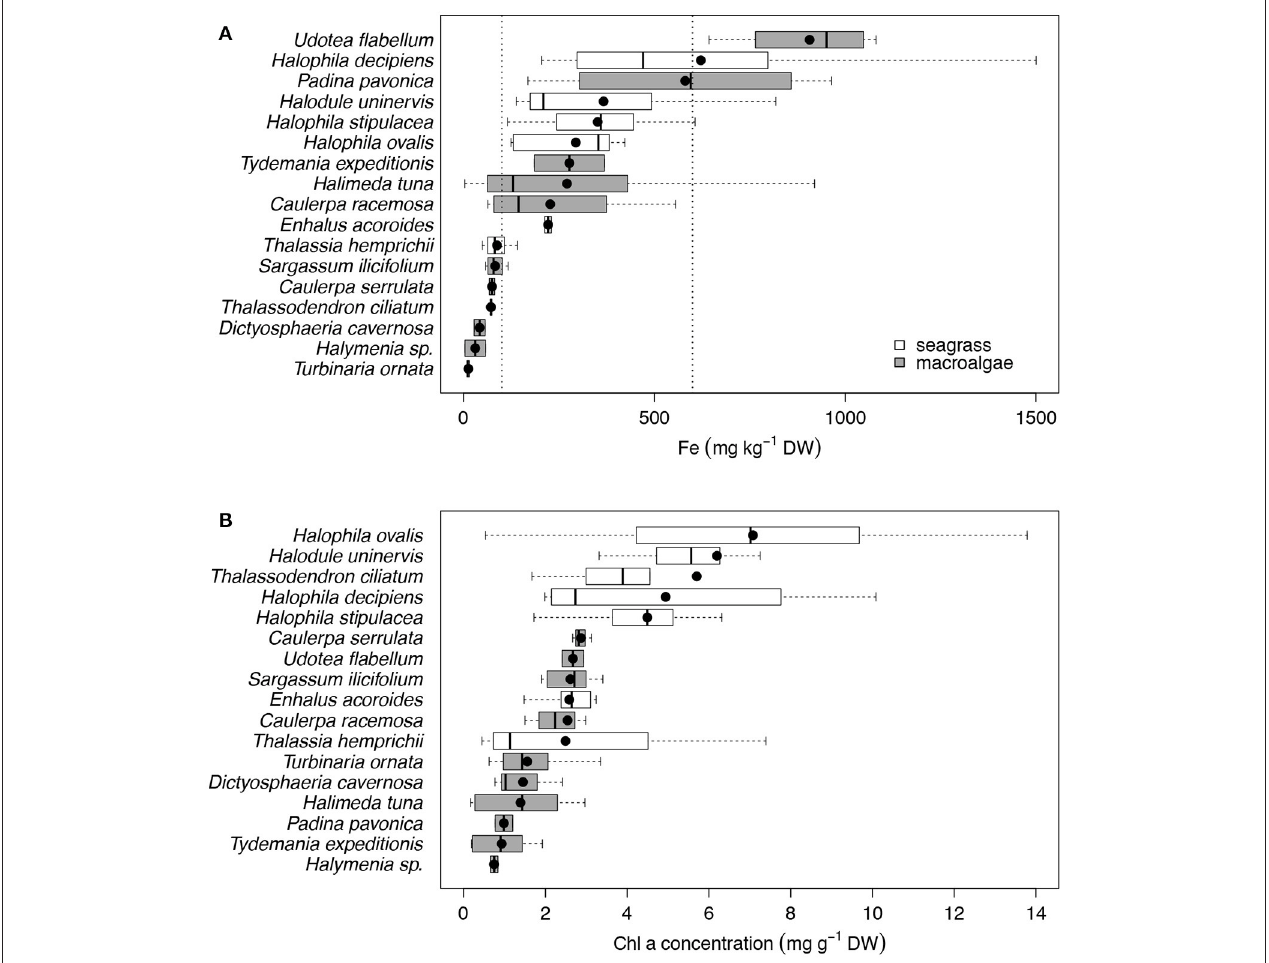
FIGURE 2 | Box plots of the iron concentration (mg kg − 1 DW; A ) and the Chl a concentration (mg g − 1 DW; B ) for the 17 species of primary producers ordered by increasing mean values for the Red Sea, which are represented with black dots. Seagrass species are represented in white and macroalgae species in gray. Vertical dash lines indicate critical and sufficient iron concentrations at 100 and 600mg Fe kg DW − 1 , respectively. The number of replicates is indicated in Table 2 .